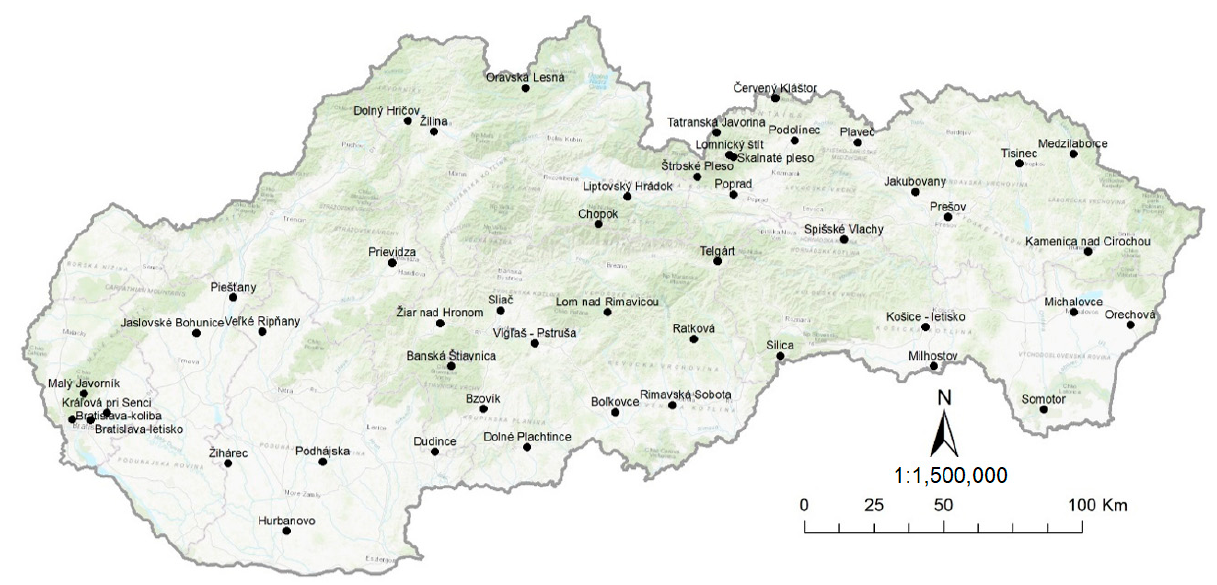
Figure 3. Location of precipitation stations in Slovakia . Table 1. List of observed stations with their altitude and location.